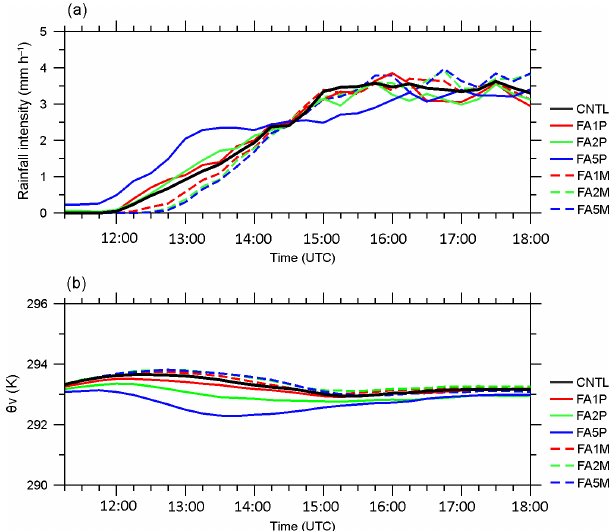
Figure 16. Temporal evolution of domain-averaged rainfall inten- sity (mmh − 1 ) and virtual potential temperature ( θ v ) at the first model level in a fixed domain of 43–44.5 ◦ N, 5.5–7.5 ◦ E, where most of the precipitation is produced by CNTL (black line), FA × P (solid lines), and FA × M (dashed lines) from 11:15 to 18:00UTC on 14 October